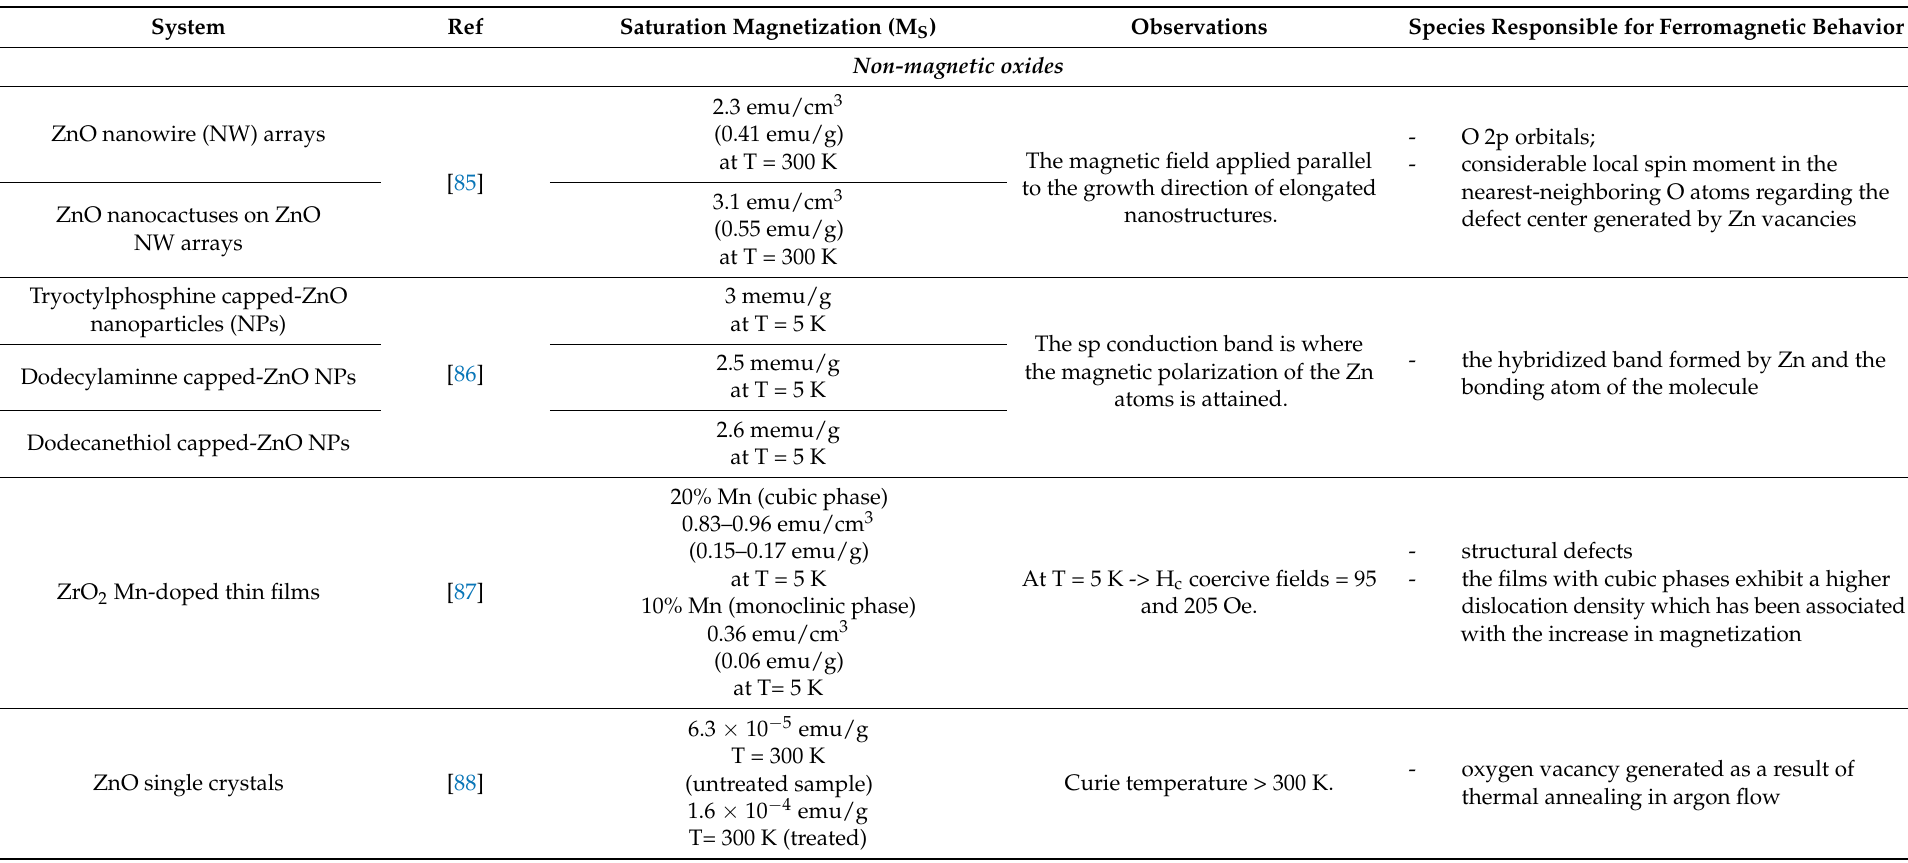
Table 1. Comparison between different material magnetization and their potential